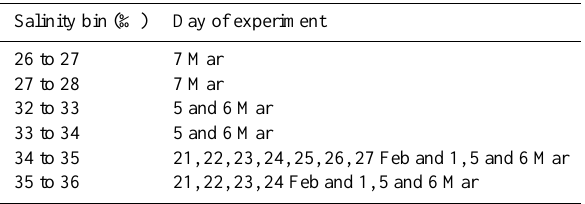
Table 3. Salinity bins and the days from which the median total particle number concentration for the different water temperature bins was calculated.